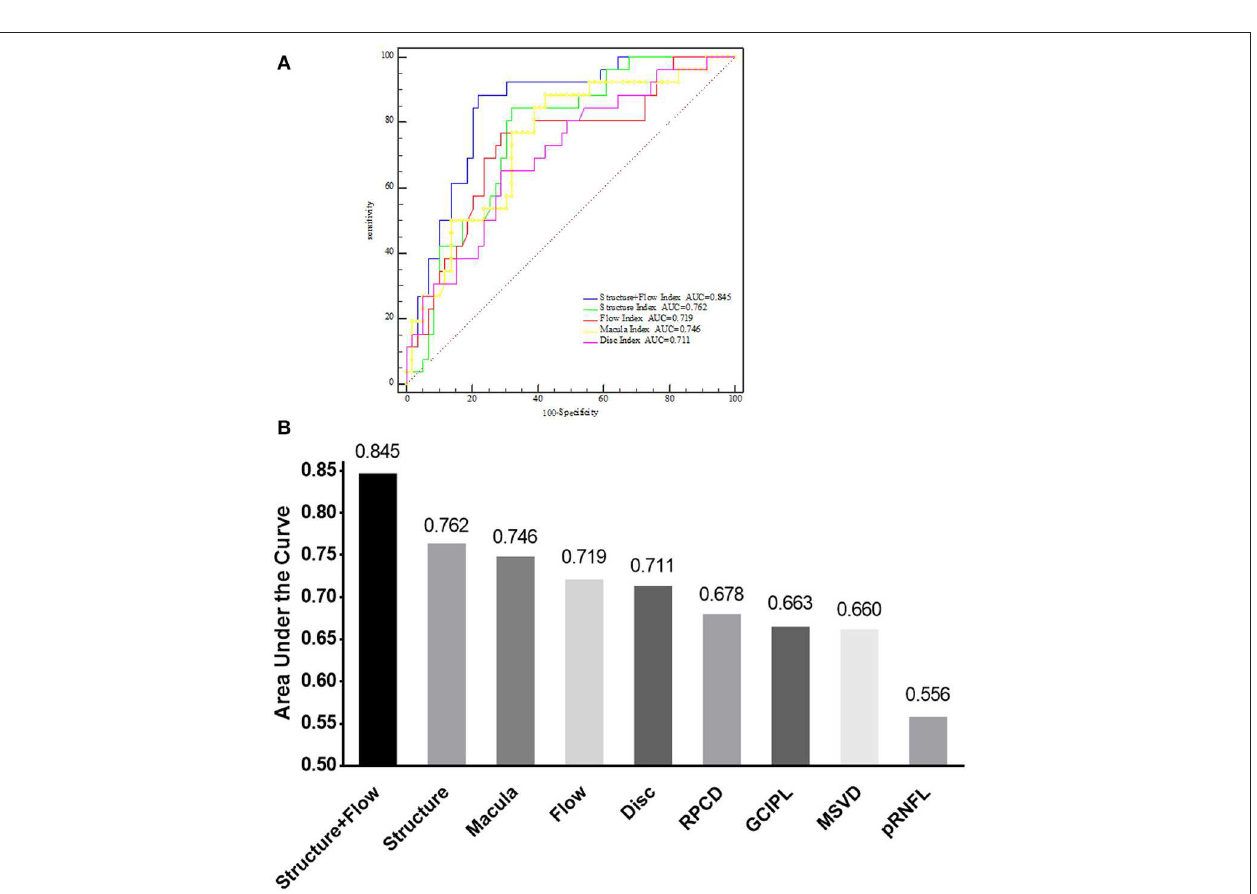
Frontiers in Neurology |